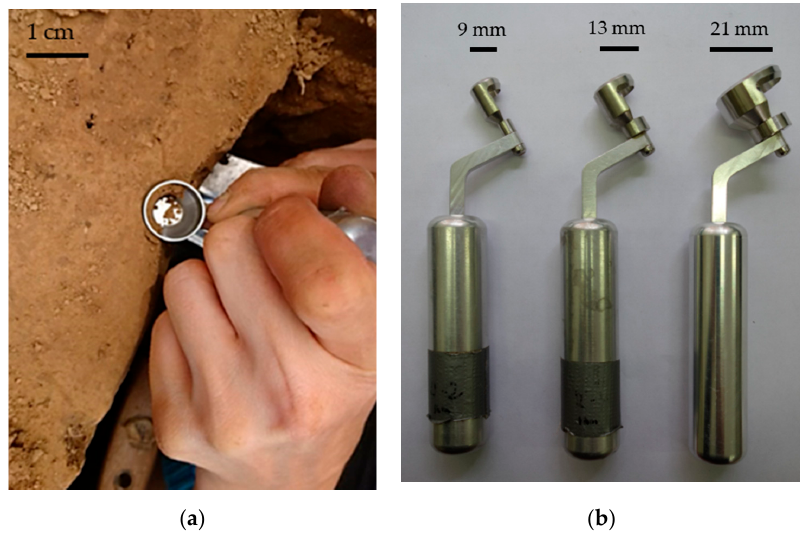
Figure 1. Biopore sheath scraping device: ( a ) sampling biopore sheath of 2–4 mm distance from macropore; ( b ) scraping device in different sizes.